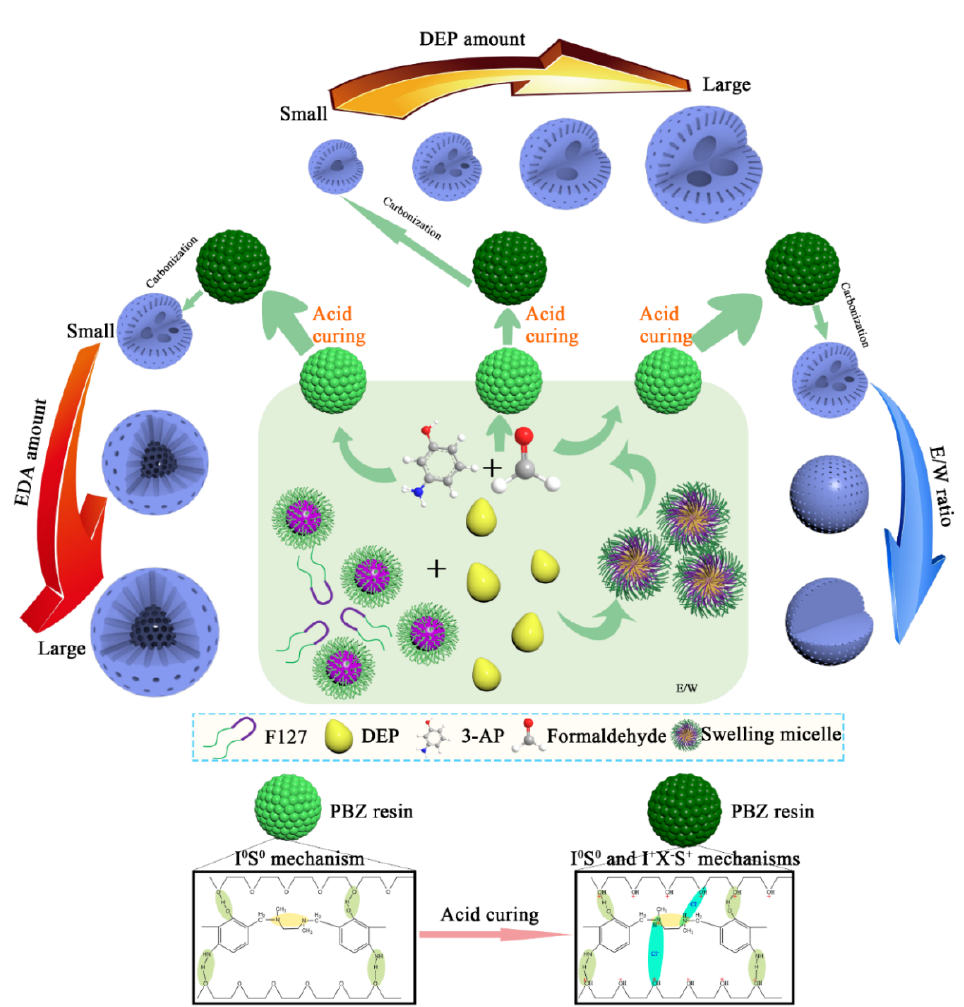
Figure 9. A schematic illustration for the formation mechanism of various NMMCNs-x.